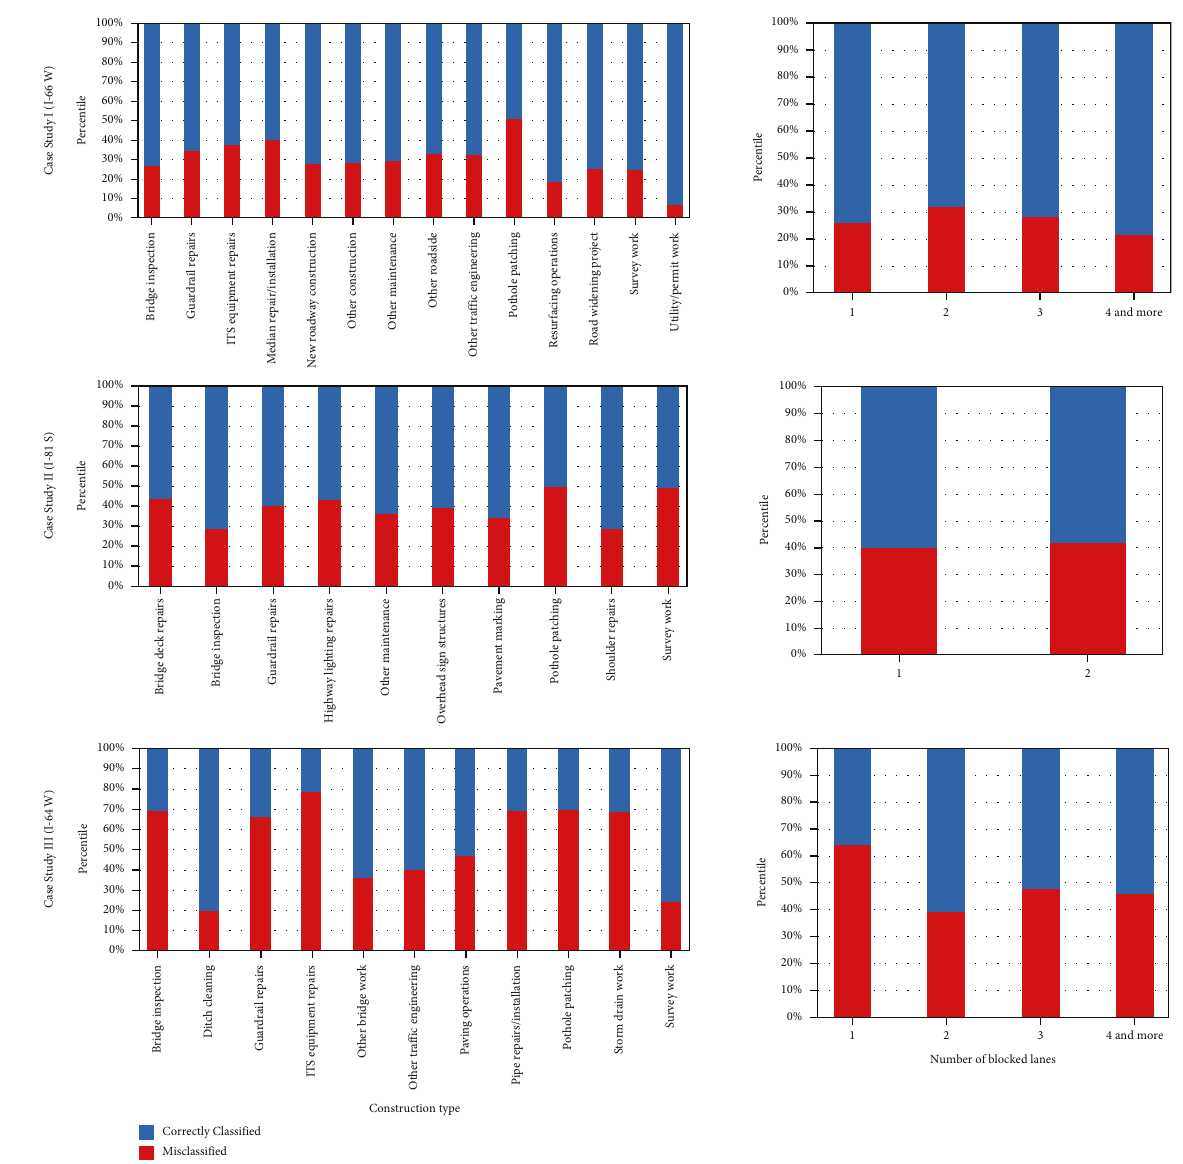
Figure 6: Improvement detection rates conditioned on types and number of blocked